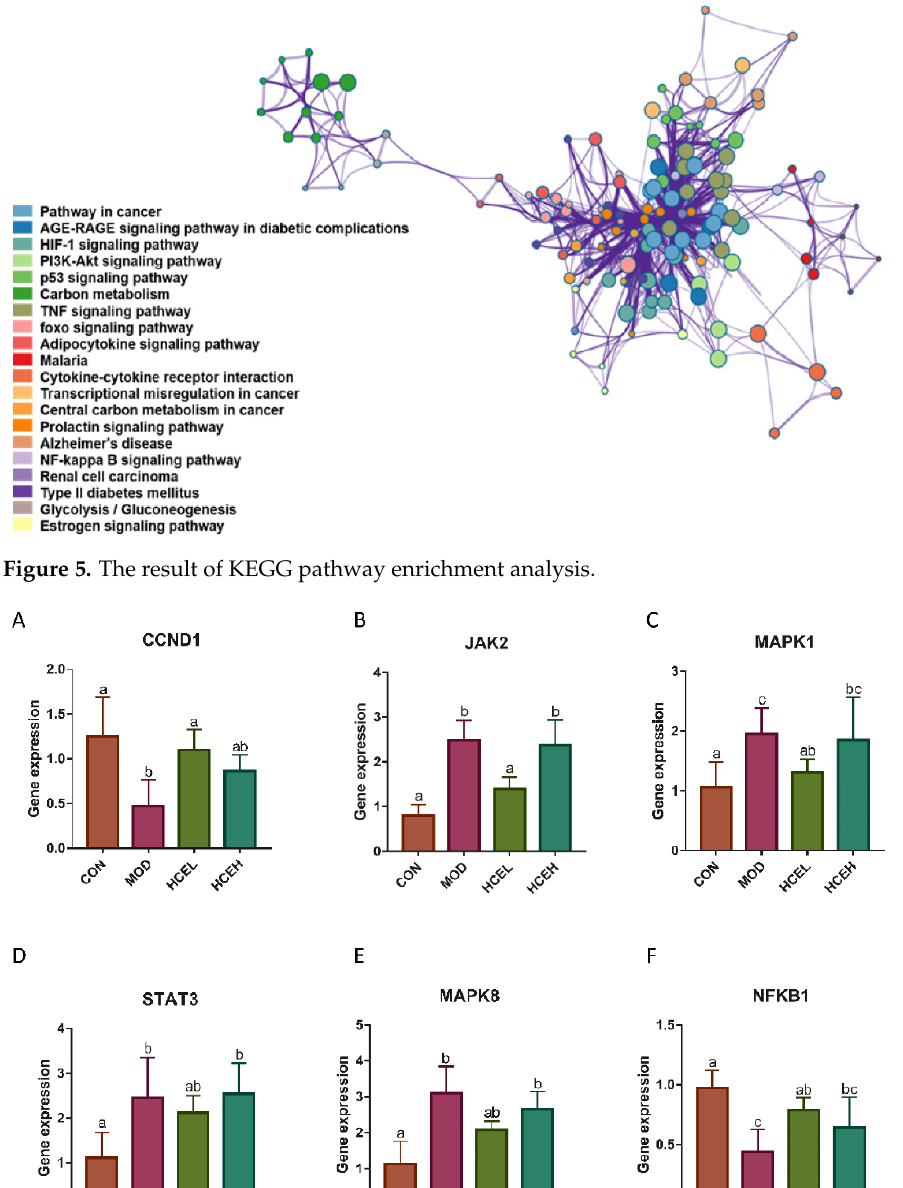
Figure 5. The result of KEGG pathway enrichment analysis.